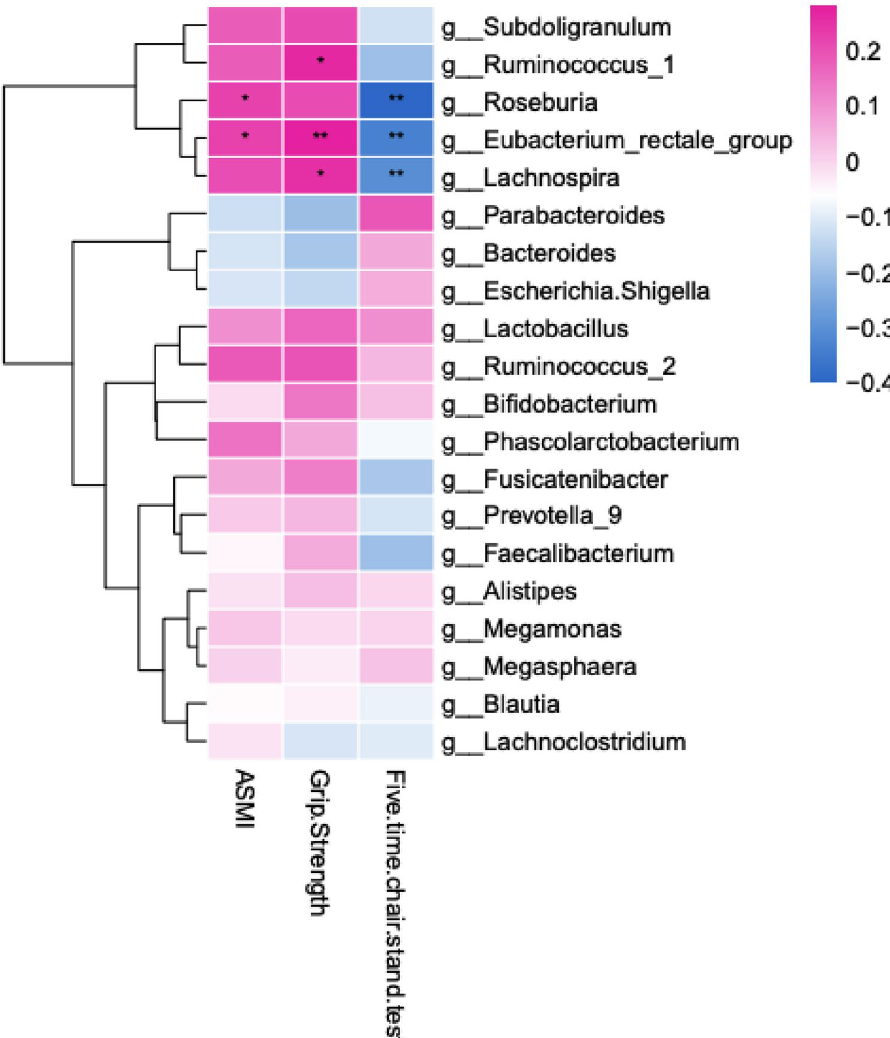
Figure 5. Heatmap showing correlations between microbiota genera and sarcopenic characteristics. Abundance (based on sequence counts) of microbiota genera correlate with muscle mass (ASMI) and functional muscle tests (grip strength, five-time chair stand test). The intensity of the color represents the correlation with the corresponding characteristics (negative correlation, blue; positive correlation, pink). ASMI, appendicular skeletal muscle index. Spearman test, *p < 0.05, **p <